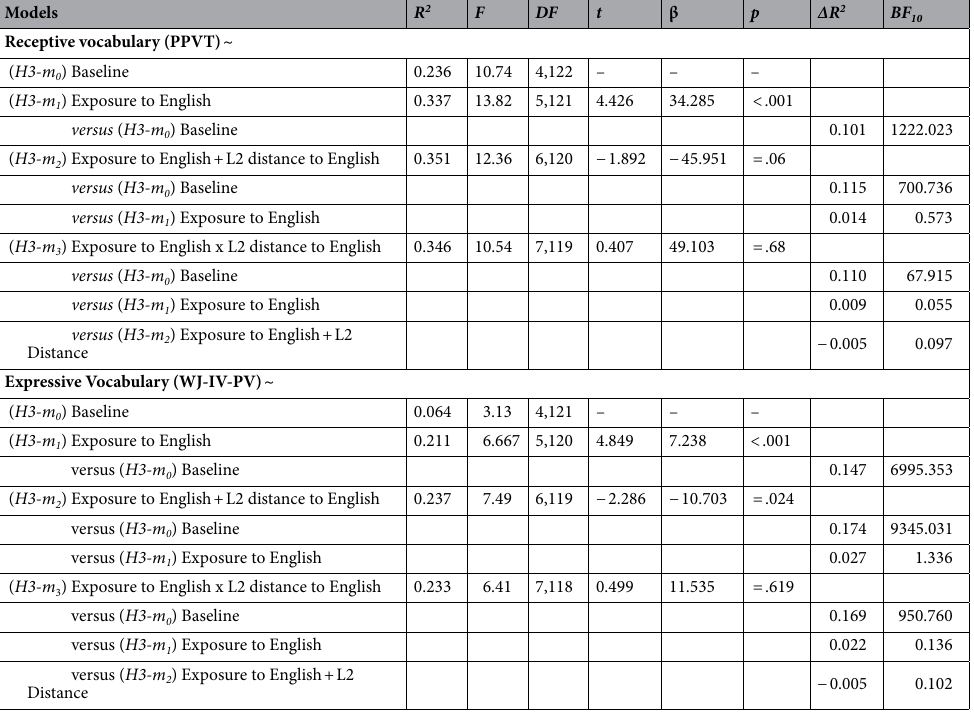
Table 5. Multiple regression models’ parameters and BF 10 testing Hypothesis 3 in a bilingual sub-sample of